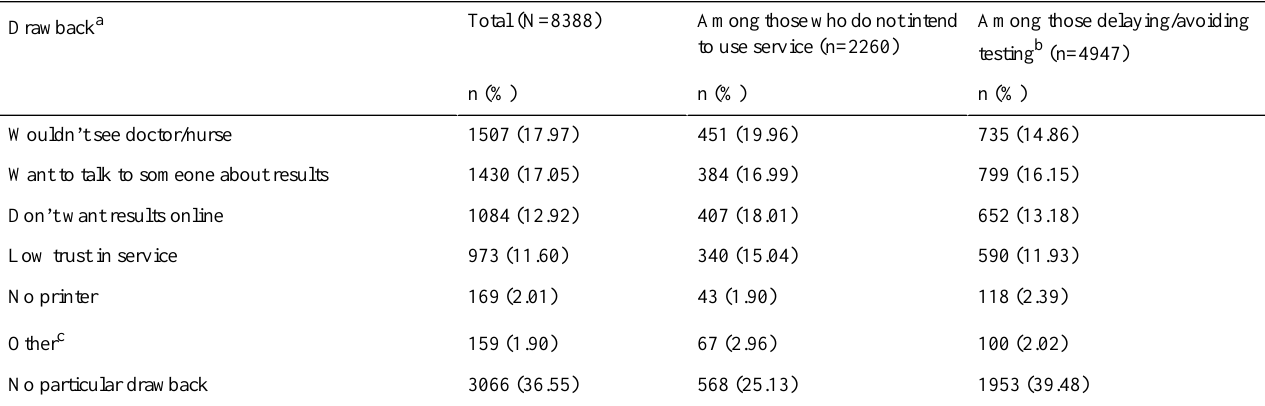
Table 2. Greatest perceived drawback to Internet-based STI and HIV testing among the survey sample of Canadian gay and bisexual men.